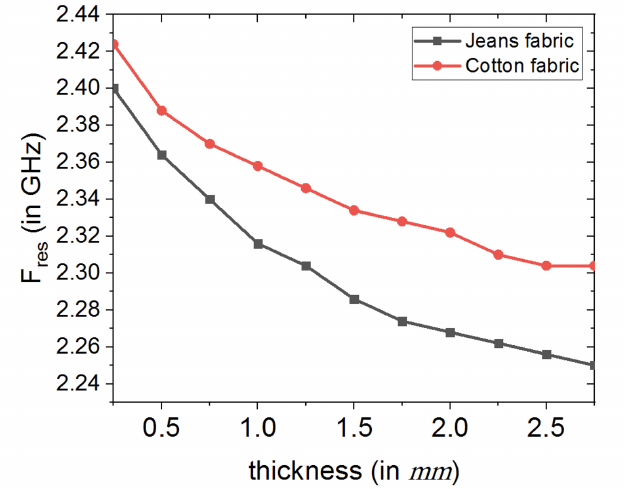
Figure 7. Numerical study of the effect of textile fabrics’ thickness on loop antenna’s resonance